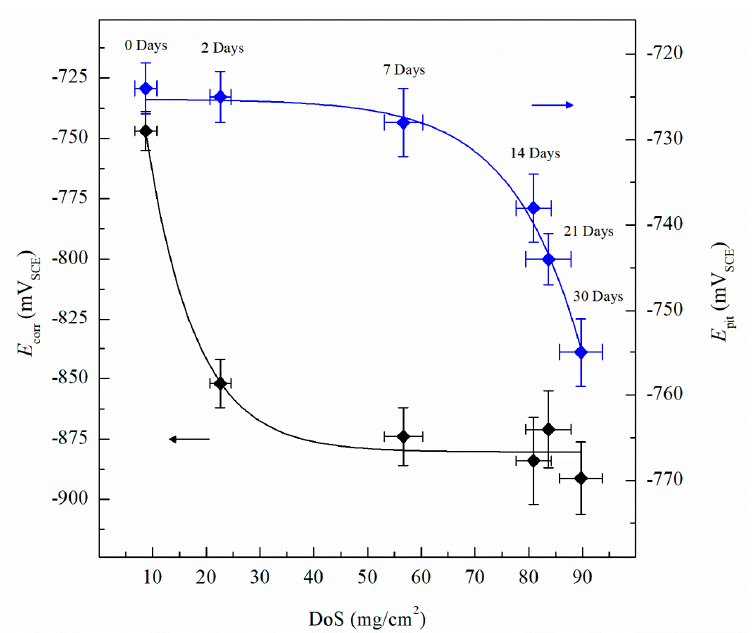
Figure 5. Average corrosion potential values ( E corr ) and the average pitting potential ( E pit ) quantified from CPP for varying DoS measured by nitric acid mass loss test (NAMLT). Error bars represent standard deviation from the mean.